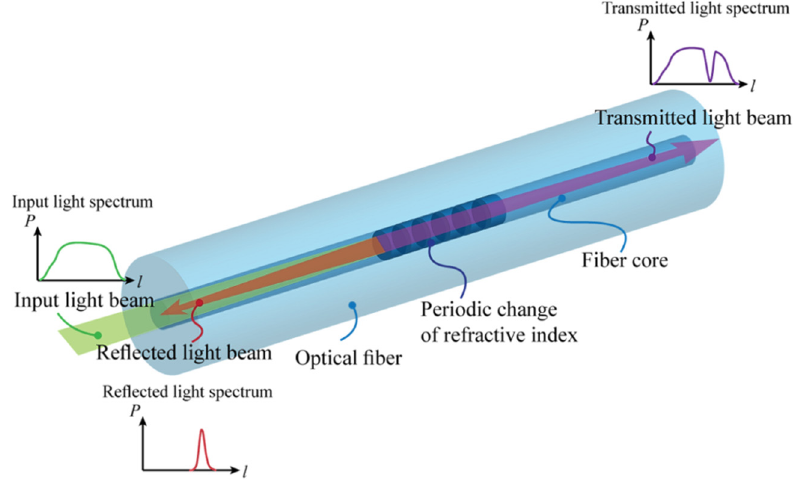
Figure 4. Principle of function of FBG sensors in spectral area as a part of optical fiber sensor [23,24]. The Bragg wavelength is a function of the period of the grating, which is why FBGs can be manufactured for various wavelengths that then allow the various FBGs to reflect unique and required wavelengths of